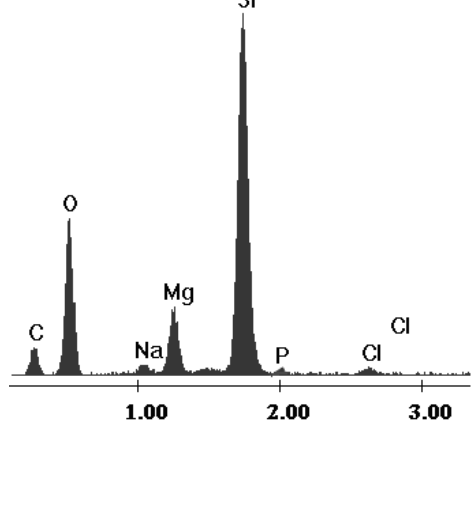
Figure 2. The EDX spectrum of the Florisil ® impregnated with